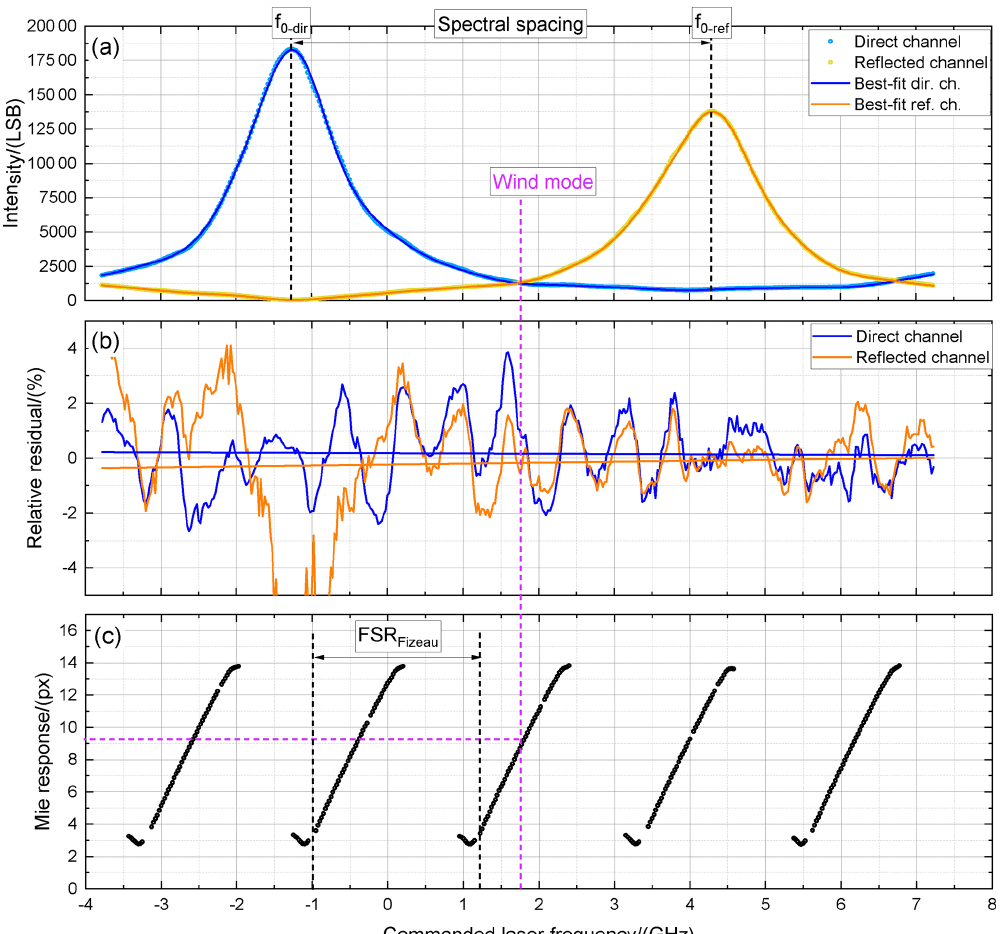
Figure 5. (a) FPI transmission curves of the direct channel (light-blue dots) and the reflected channel (yellow dots) measured on 10 October (f ) (see also Eq. 2), and the corresponding best fits according to Eqs. (9) and (11) in blue 2018, laser-energy-corrected by means of E norm new (direct channel) and orange (reflected channel), respectively. (b) Related relative residuals of the direct channel (blue) and reflected channel (orange). (c) Corresponding Mie response, i.e., the fringe center position on the ACCD